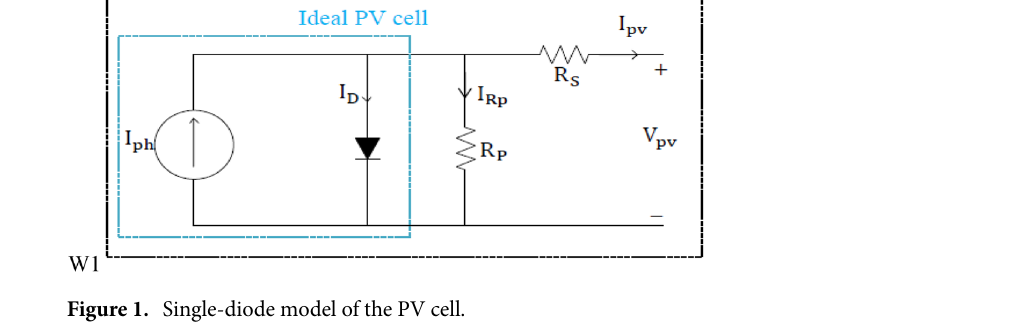
Figure 1. Single-diode model of the PV